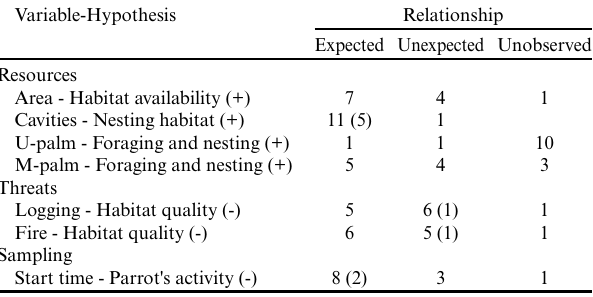
Table 5 . Summary of relationships between hypotheses and the model-averaged estimates for 12 parrot species on 60 forest islands of Beni savannas, Bolivia. The number of species for which intervals of estimates did not overlap zero is shown in